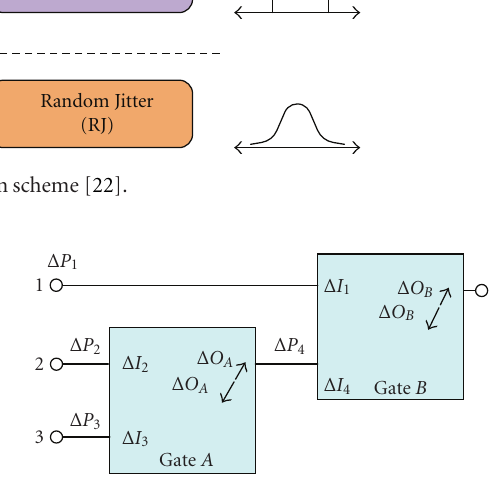
Figure 5: Timing model, example